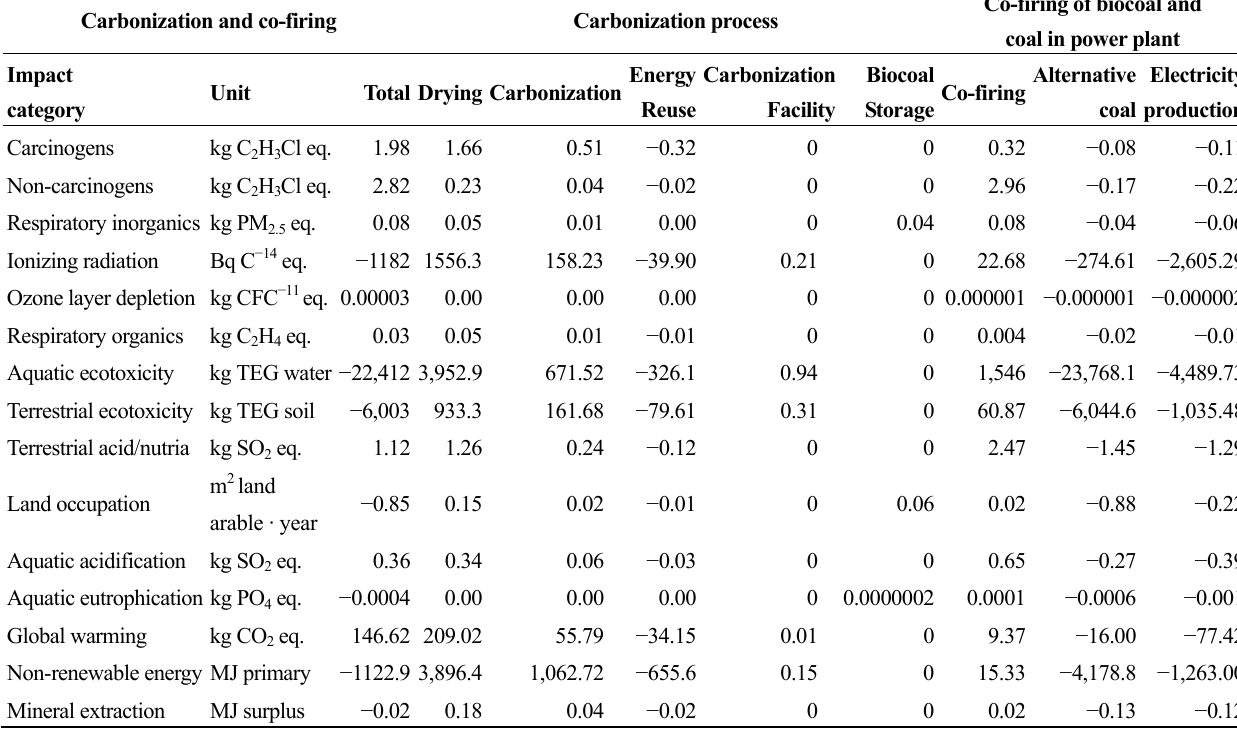
Table 2. Characterization of the carbonization